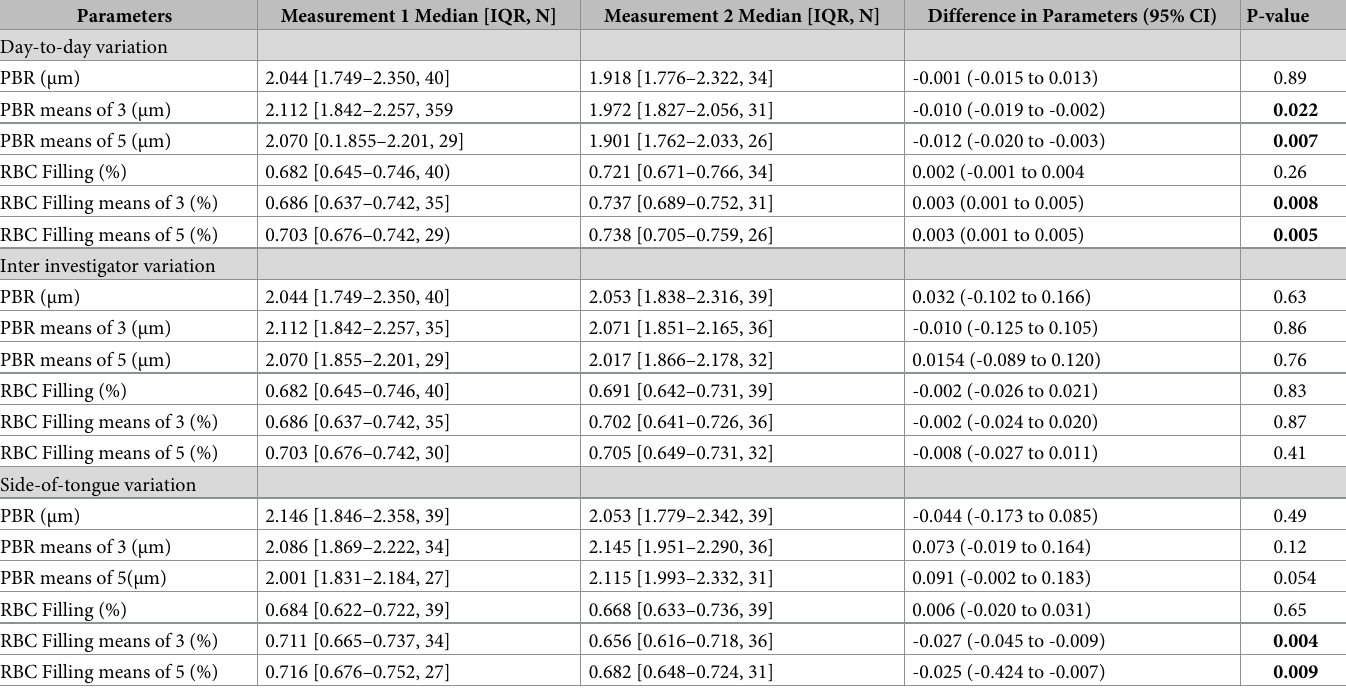
Table 2. Variations between days, investigators and side-of-tongue based on single, or mean of three and five measurements.